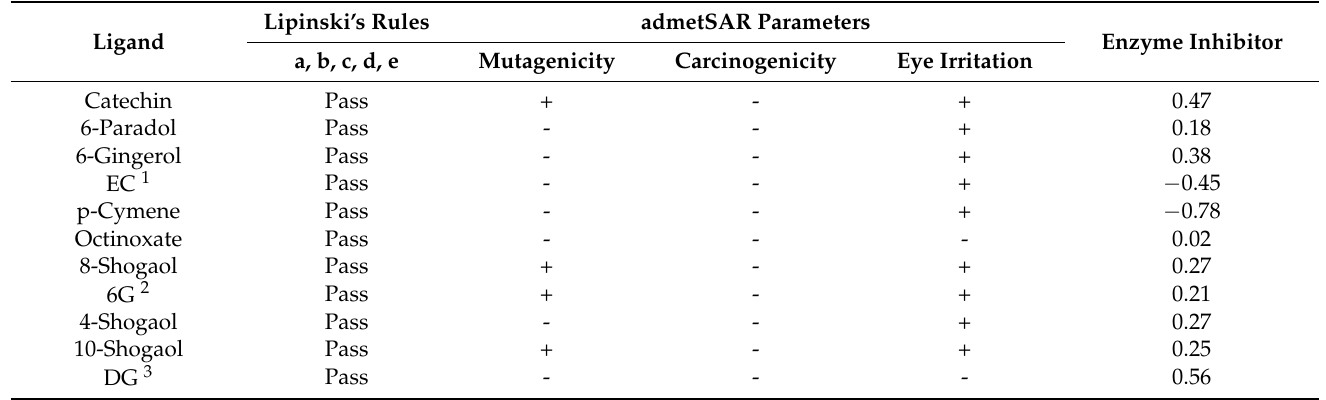
Table 3. Ligand evaluation using Lipinski’s rules and admetSAR